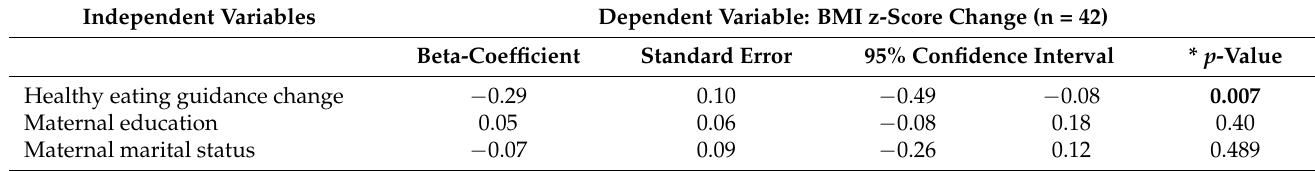
Table 9. Multivariate regression analysis results between healthy eating guidance change and BMI z-score